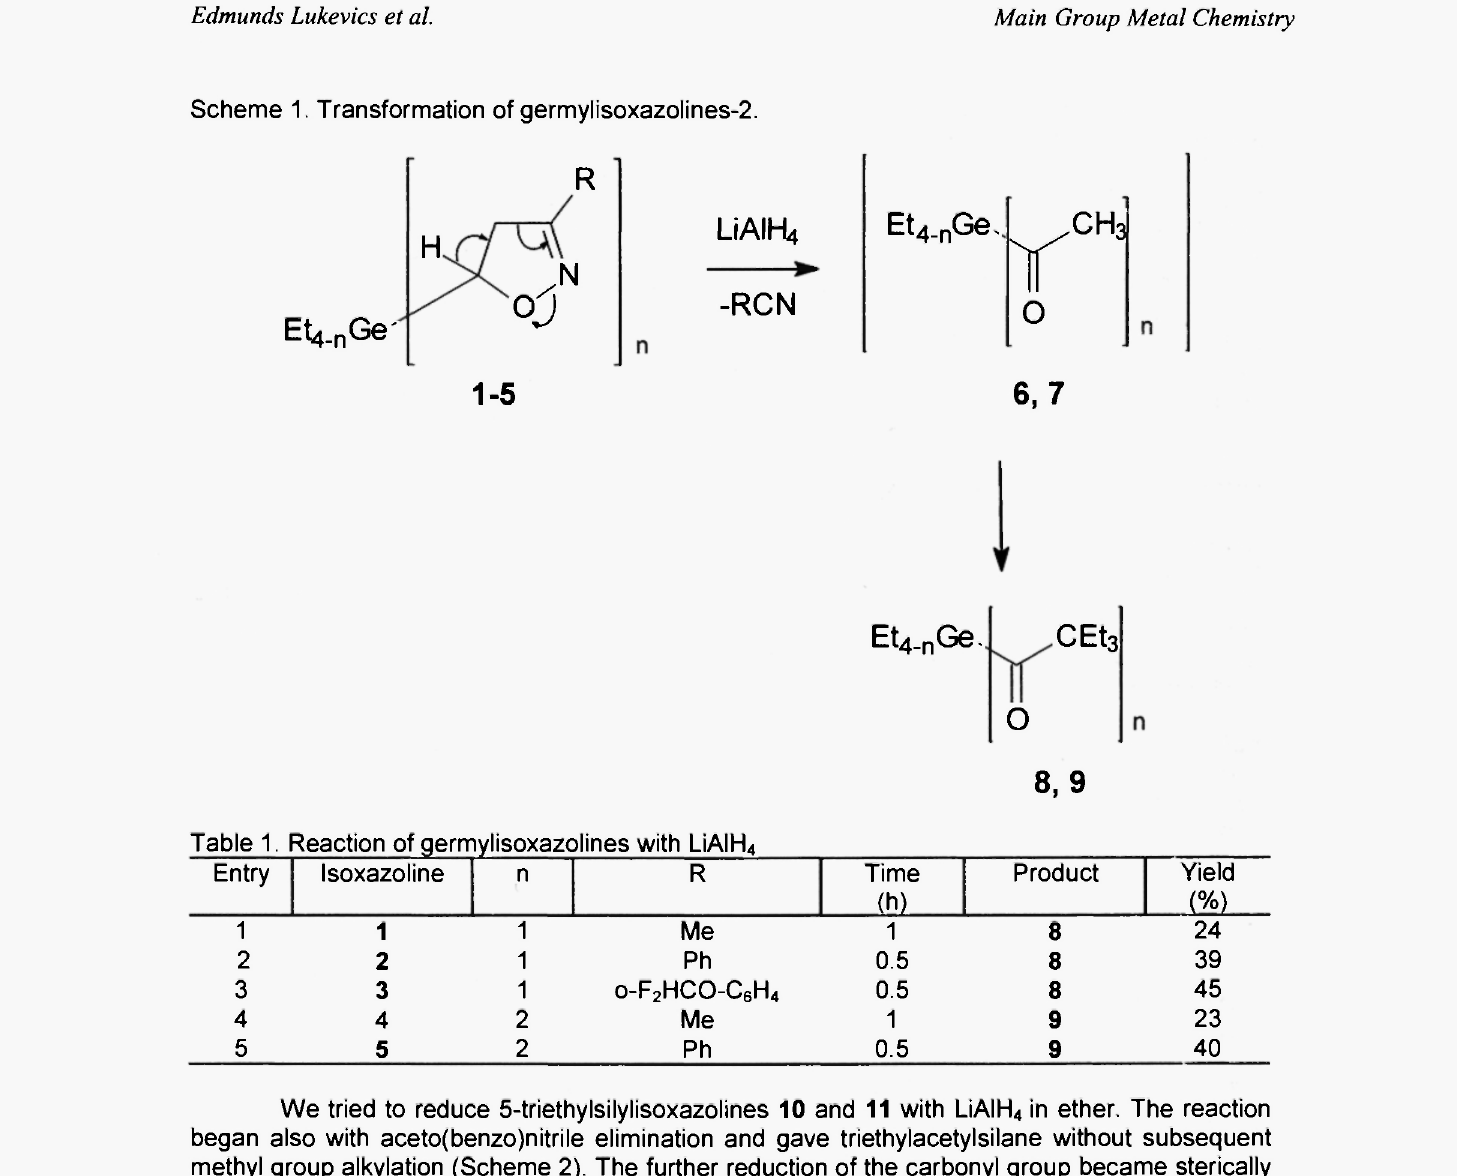
Table 1. Reaction of germylisoxazolines with LiAIH 4